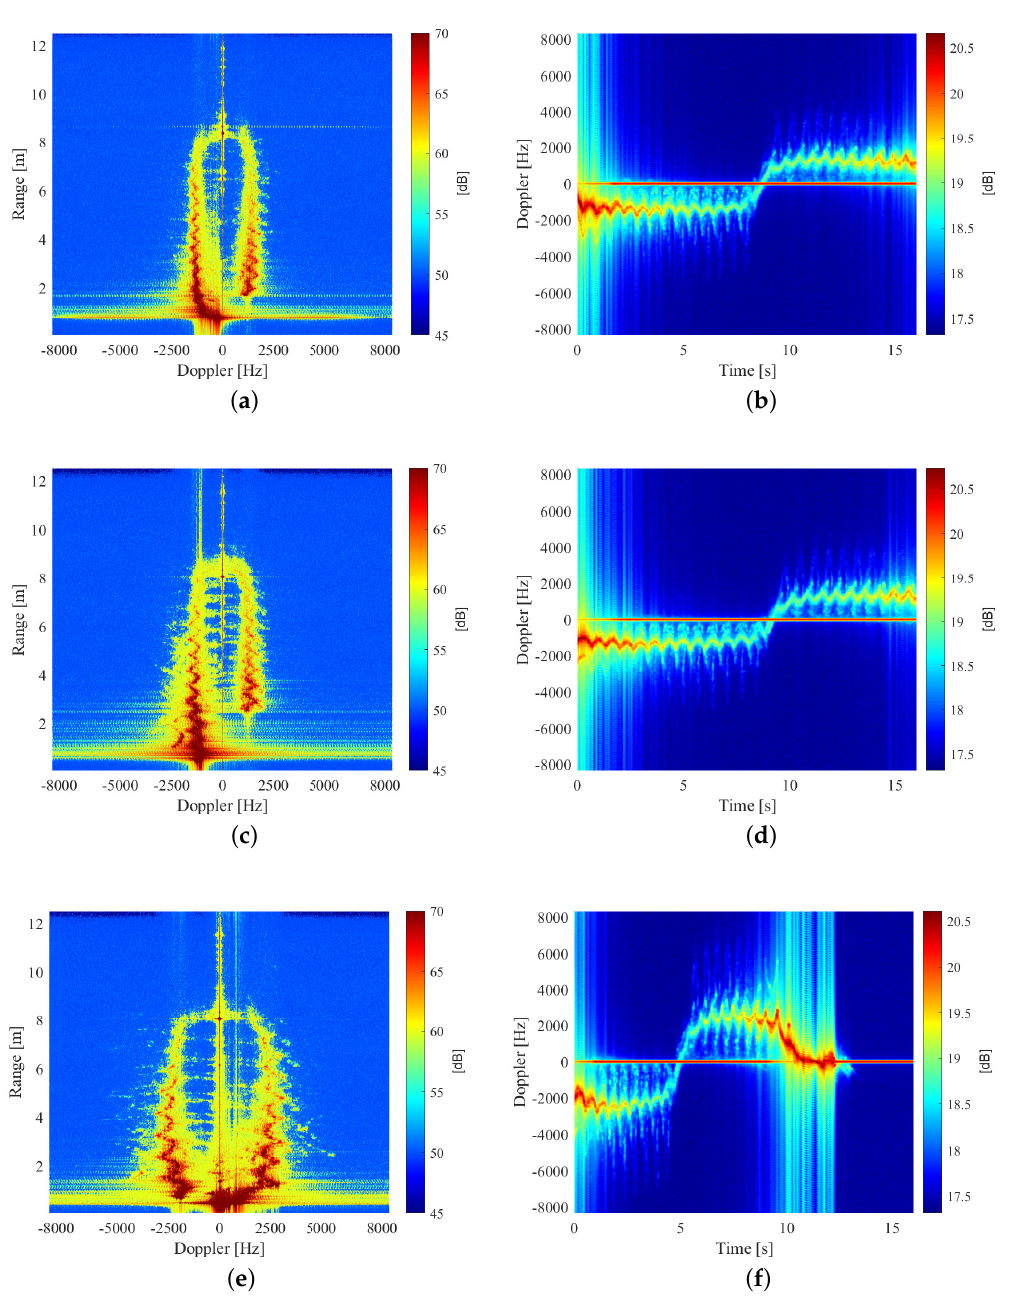
Figure 8. Example of a person walking slowly ( a , b ), slowly with hands in pockets ( c , d ) and fast ( e , f